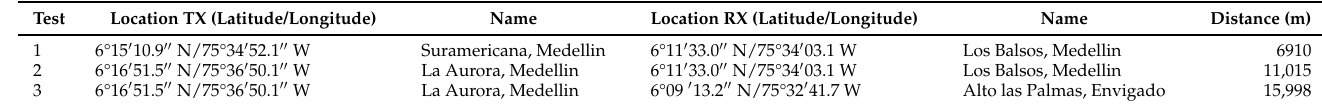
Figure 7. ( a ) Vertical cut and Fresnel distance. ( b ) Spatial intensity over the Aburra Valley and ( c ) model generated from the different signal intensities and experimental locations. Table 1. Locations selected for the long-range transmission test. This gradual increase of successful experiments assures us of the long-range and stable communication link possible with the modules.